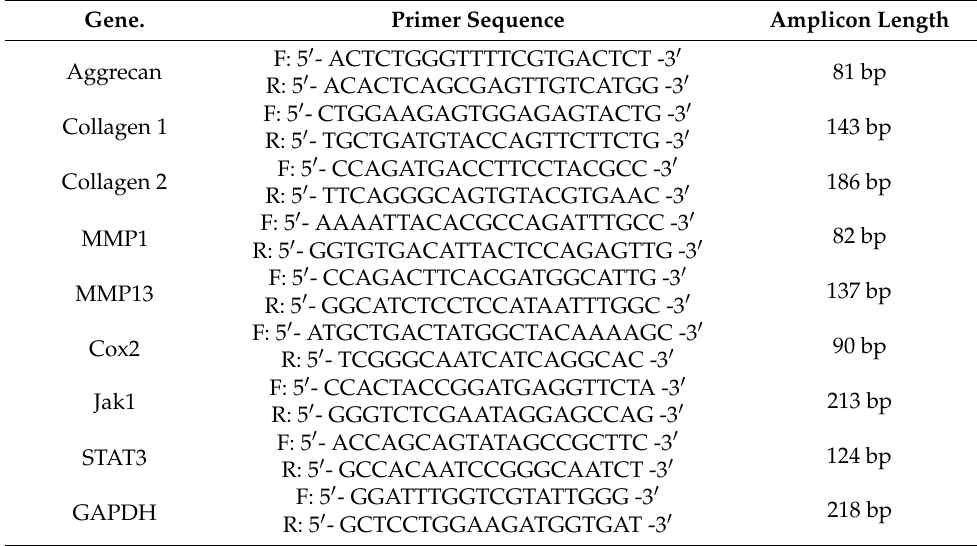
Table 1. List of primer sequences used for quantitative real-time PCR.